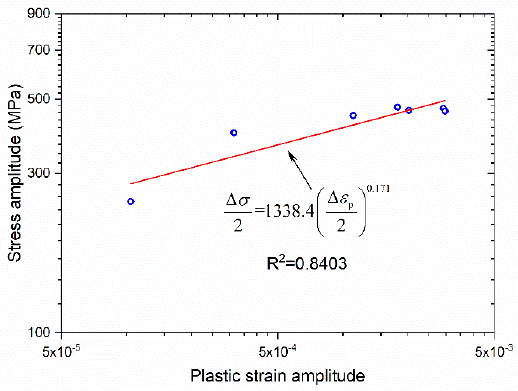
Figure 4. The cyclic stress strain relation of Inconel 625 at 815 °C.